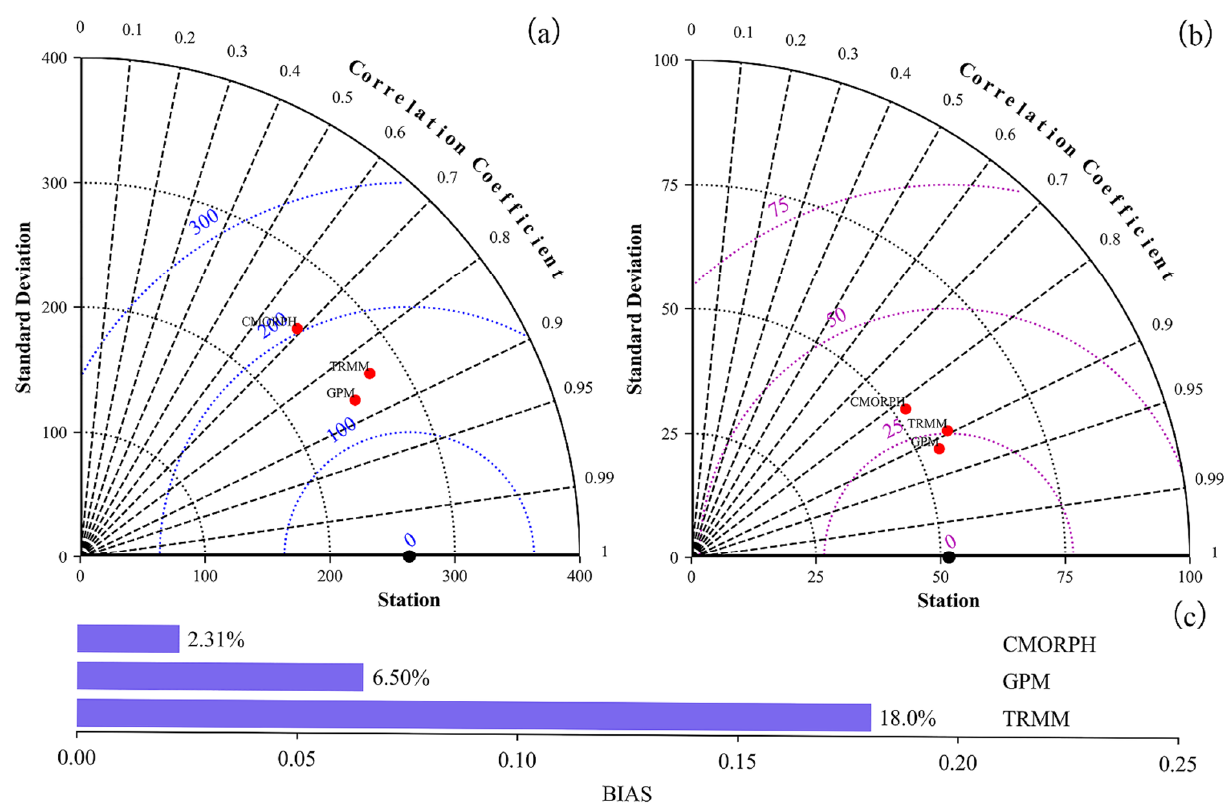
Figure 7. Taylor plots between three remote sensing precipitation products and ground station data at the ( a ) annual and ( b ) monthly scales and ( c ) the bar plot of relative